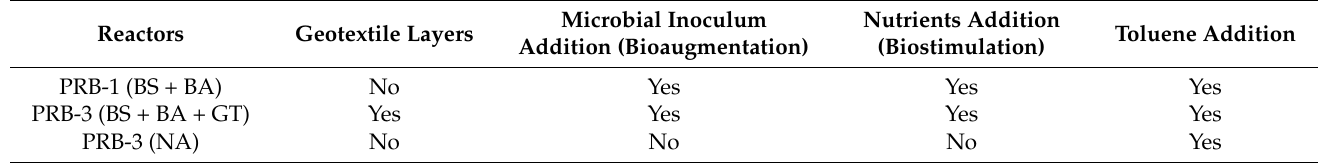
Table 2. Configuration of PRB columns.